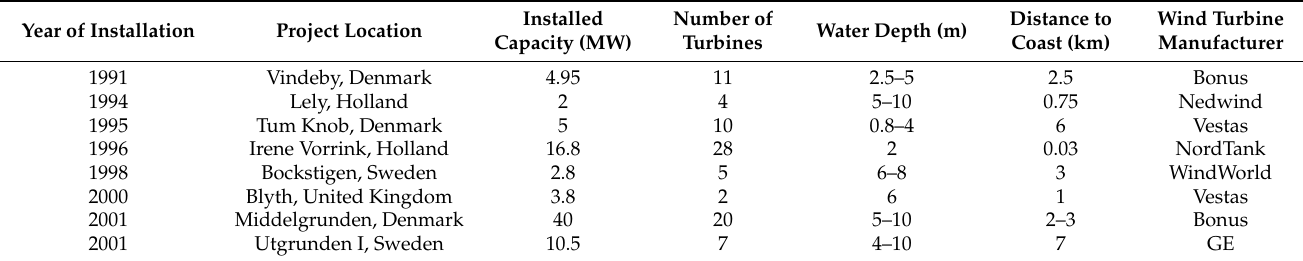
Table 1. First offshore wind farms operating in the European Union (EU). (Adapted from